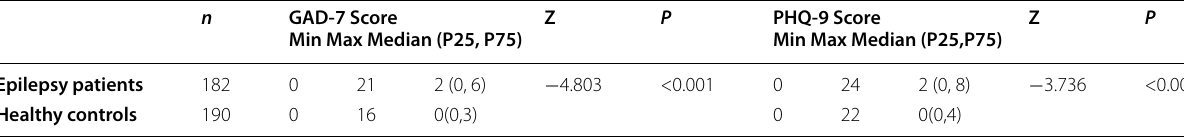
GAD-7 Generalized Anxiety Disorder-7, PHQ-9 Patient Health Questionnaire